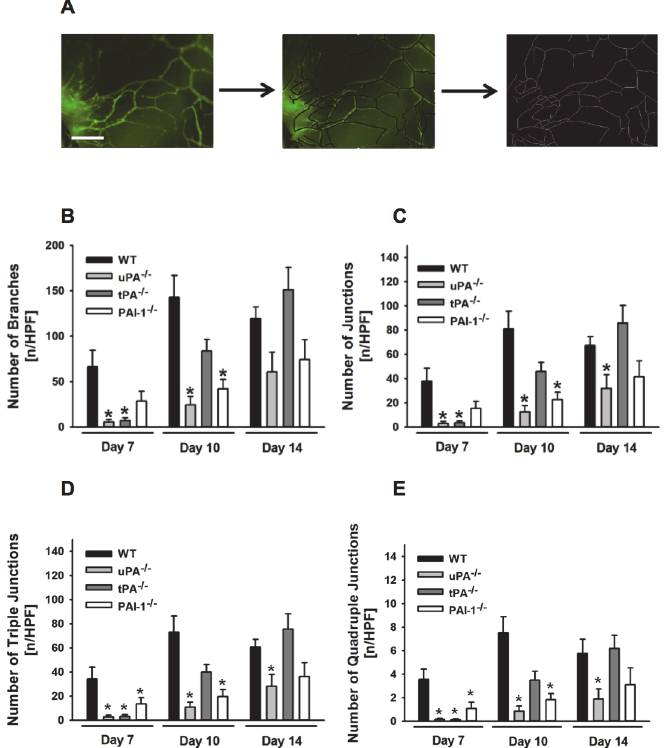
Figure 2. Role of endogenous uPA, tPA, and PAI-1 for vessel network formation in PPE biomaterial. A detailed analysis of the vessel network within the PPE implants in WT as well as in uPA-, tPA-, or PAI-1- deficient mice was performed by software-assisted skeletonizing of the vessel network. Representative images of this analysis in a WT mouse are shown ( A; scale bar: 100 μ m). Panels show results for the number of branches ( B ) and total junctions ( C ) as well as triple ( D ) and quadruple ( E ) junctions in the vessel network (mean ± SEM for n = 6; * p < 0.05 vs.